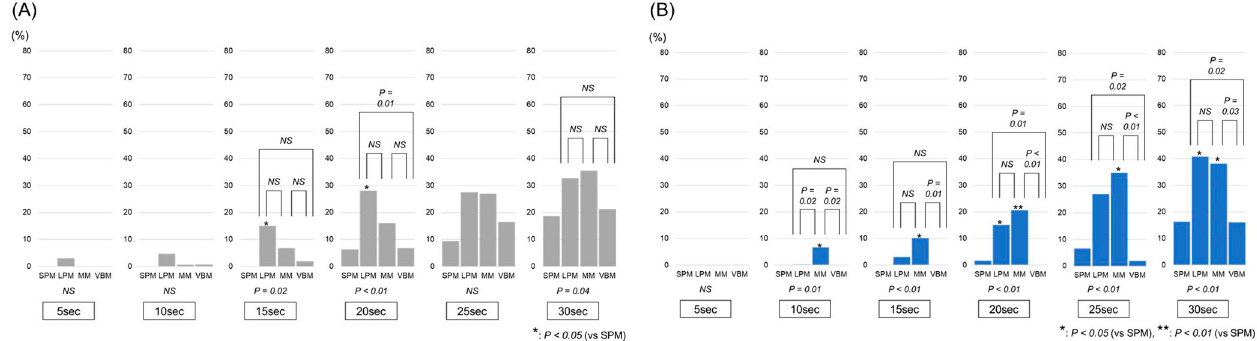
Figure 5. Comparison of the ratios of the high-temperature areas ( A ) anterior and ( B ) posterior to the laser tip. SPM: short pulse mode; LPM: long pulse mode; MM: Moses mode; VBM: virtual basket mode.